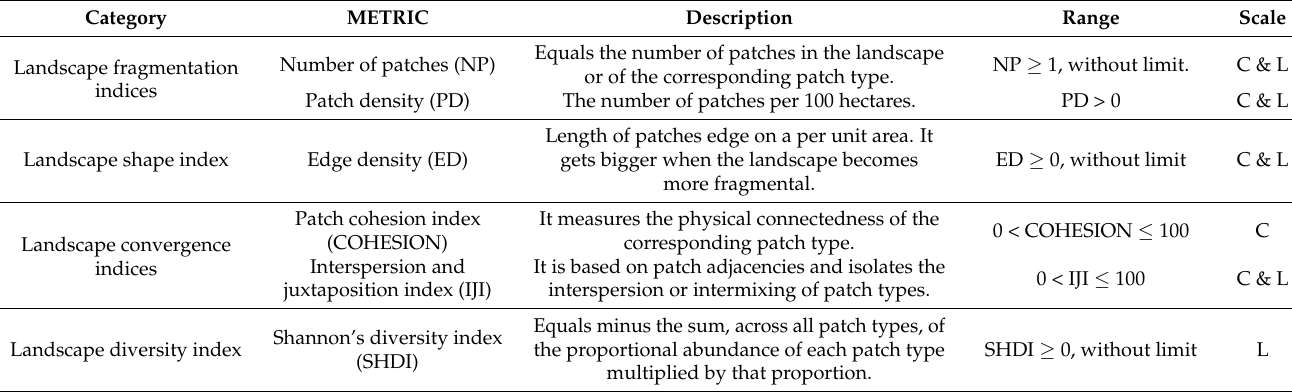
Table 2. The selected landscape indices at the class and landscape